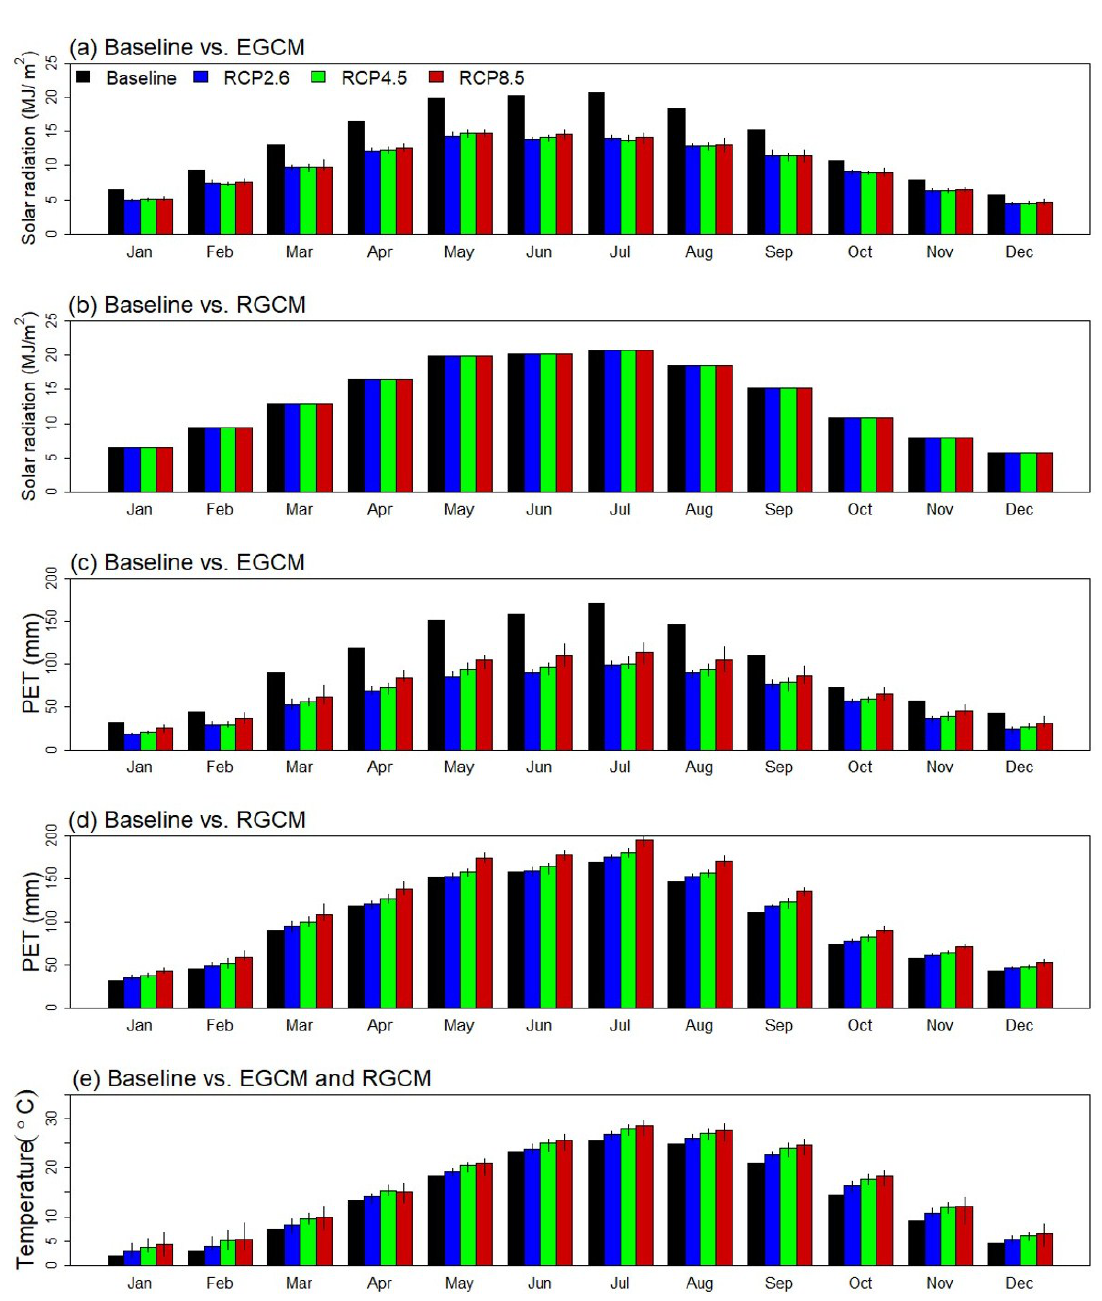
Figure 5. Comparison of the monthly average ( a , b ) solar radiation; ( c , d ) PET; and ( e ) temperature estimated using EGCM and RGCM.